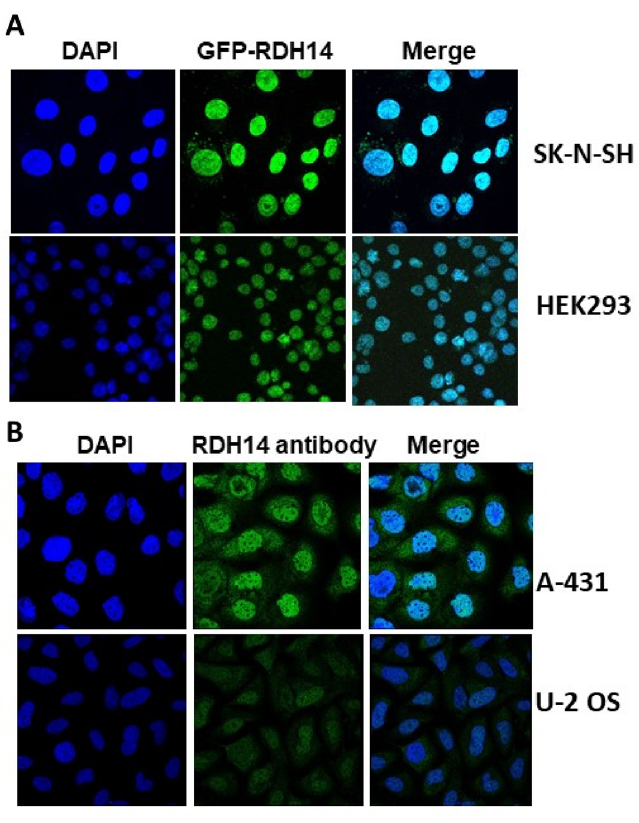
Figure 2. Cellular localization of RDH14. ( A ) using SK-NS-H cells (neuroblastoma) and HEK293T cells, transfected with RDH14-GFP in a pDEST53 construct. ( B ) Images from http:// prote inatl as. org 28 , shared under a Creative Commons Attribution License. RDH14 polyclonal antibody HPA056686 (MilliporeSigma; St Louis, MO); Human assay: A-431 fixed with PFA, dilution: 1:49; Human assay: U-2 OS fixed with PFA, dilution: